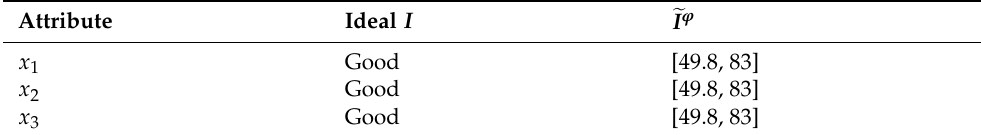
Table 4. Fuzzy sets for suppliers (agents).